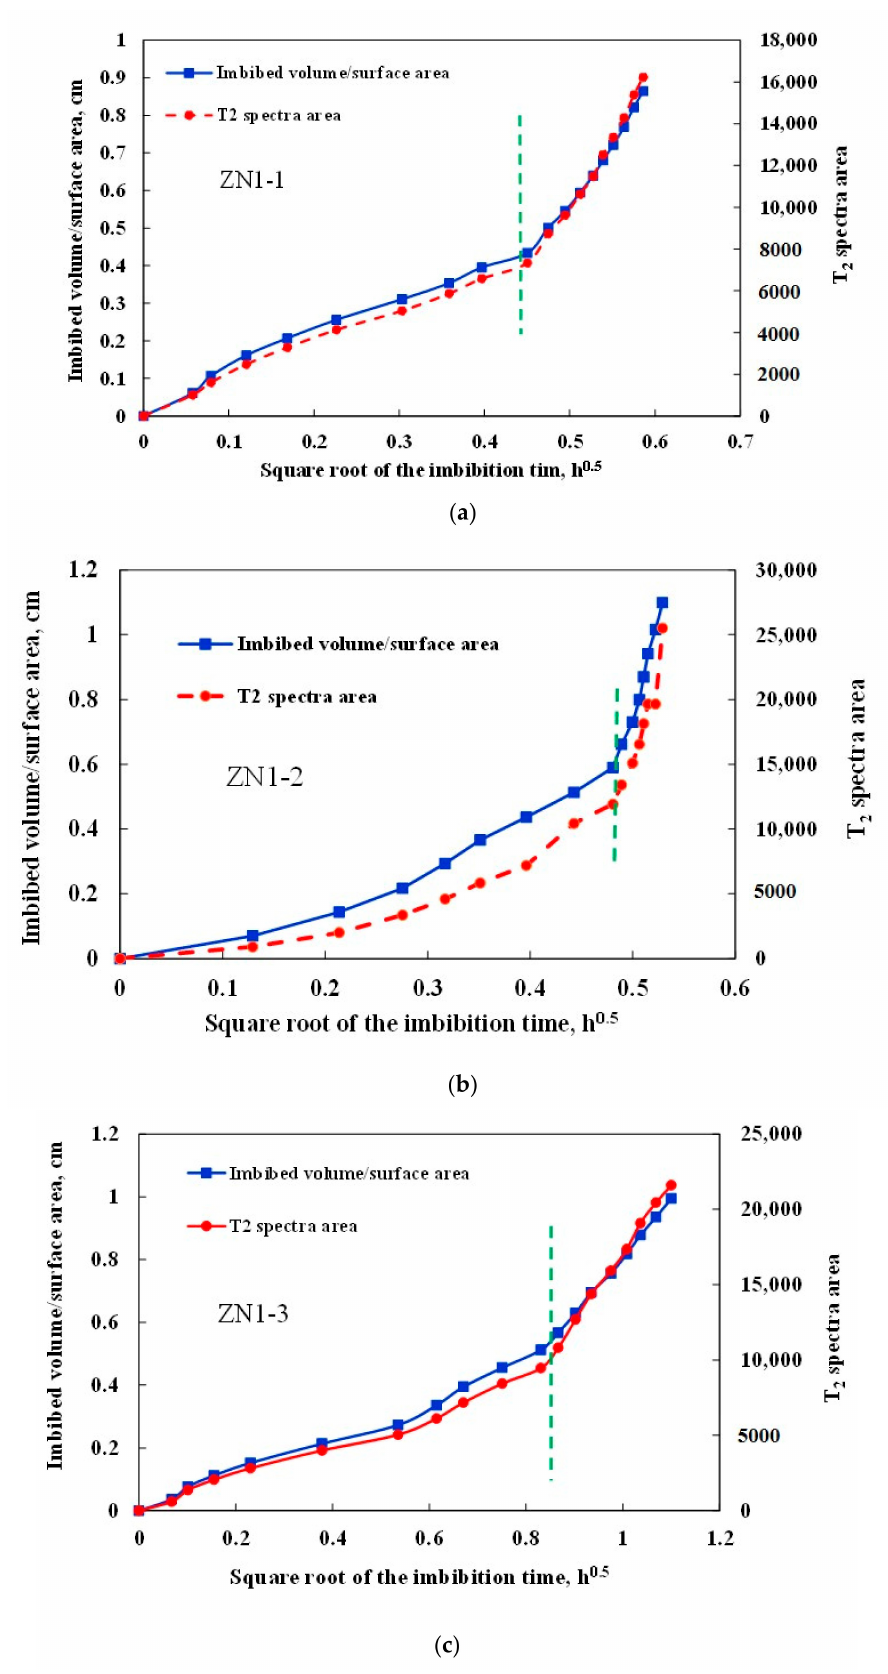
Figure 7. Imbibition volume / sectional area and spectra area vs. square root of time in ZN formation. ( a ) ZN1-1; ( b ) ZN1-2; ( c )